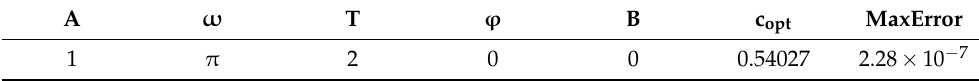
Table 1. Experimental results of Function (6).